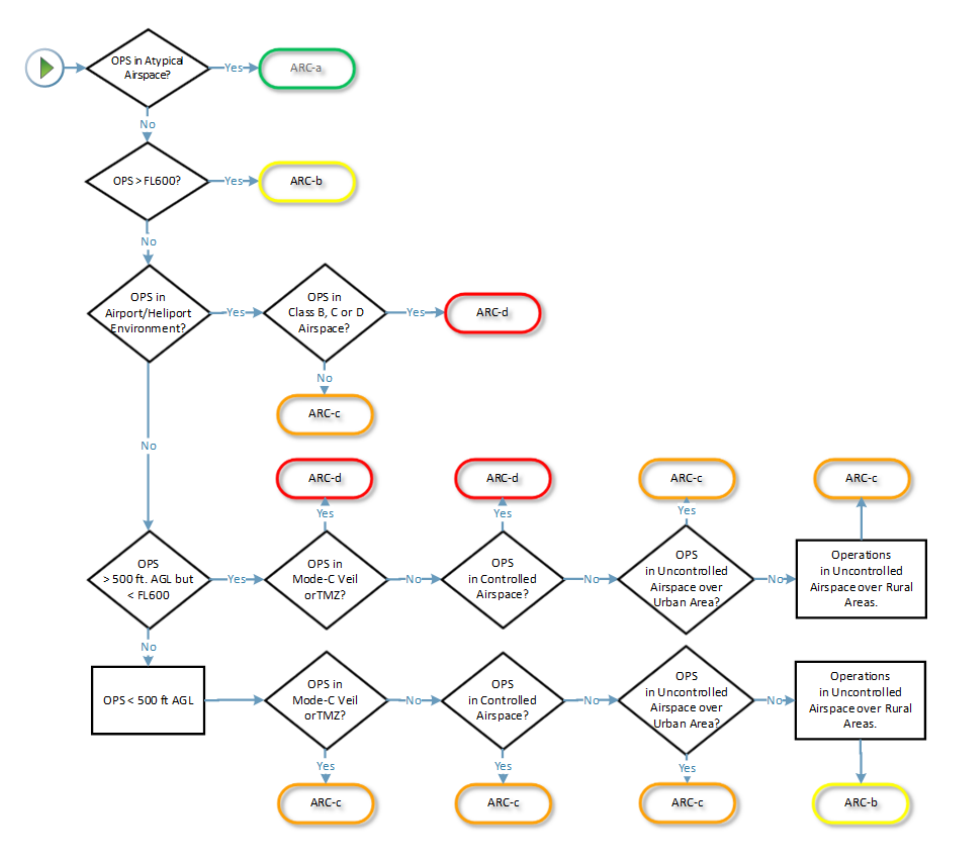
Figure 4. ARC assignment process. Reprinted with permission from [20]. Copyright (2019)